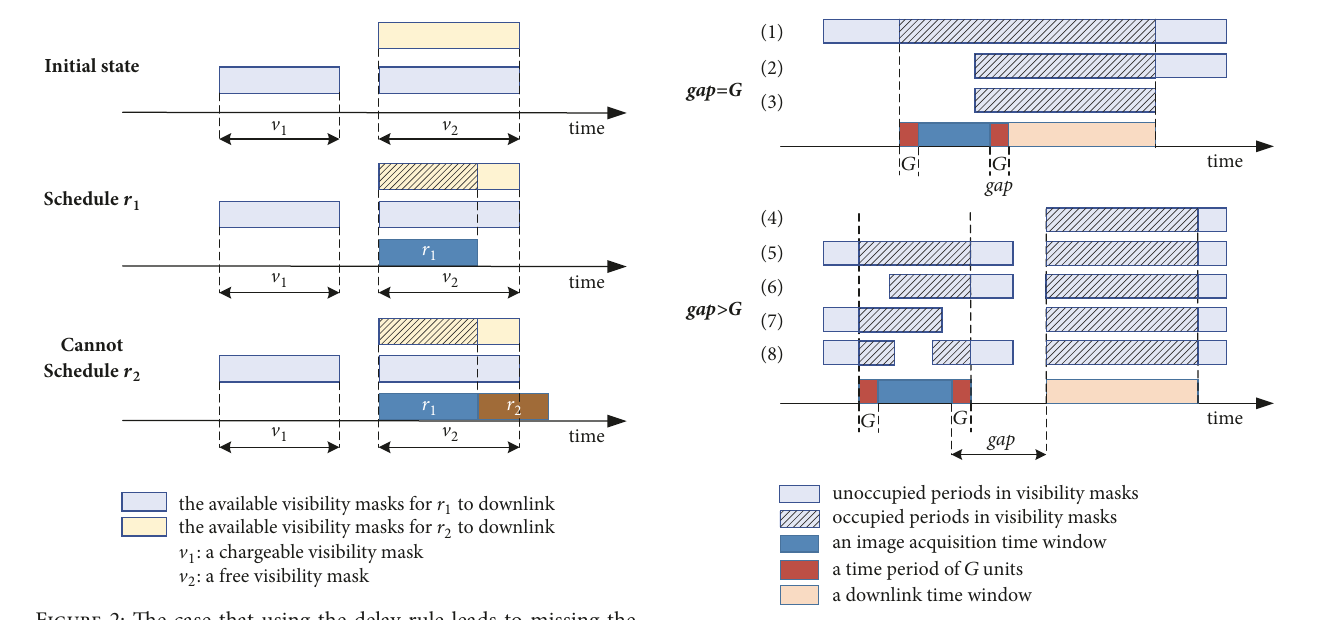
Figure 4: Visibility mask